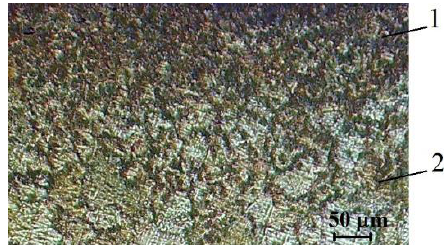
Figure 12. Structure of the near-surface layer of the L62 copper–zinc alloy after laser treatment. Etched section, the surface of which is located at an angle of about 5° to the treated surface. At such an angle of inclination, the size of studied section on the image increased by 11.4 times. 1 — near-surface layer; 2 — structure of the material without pores.